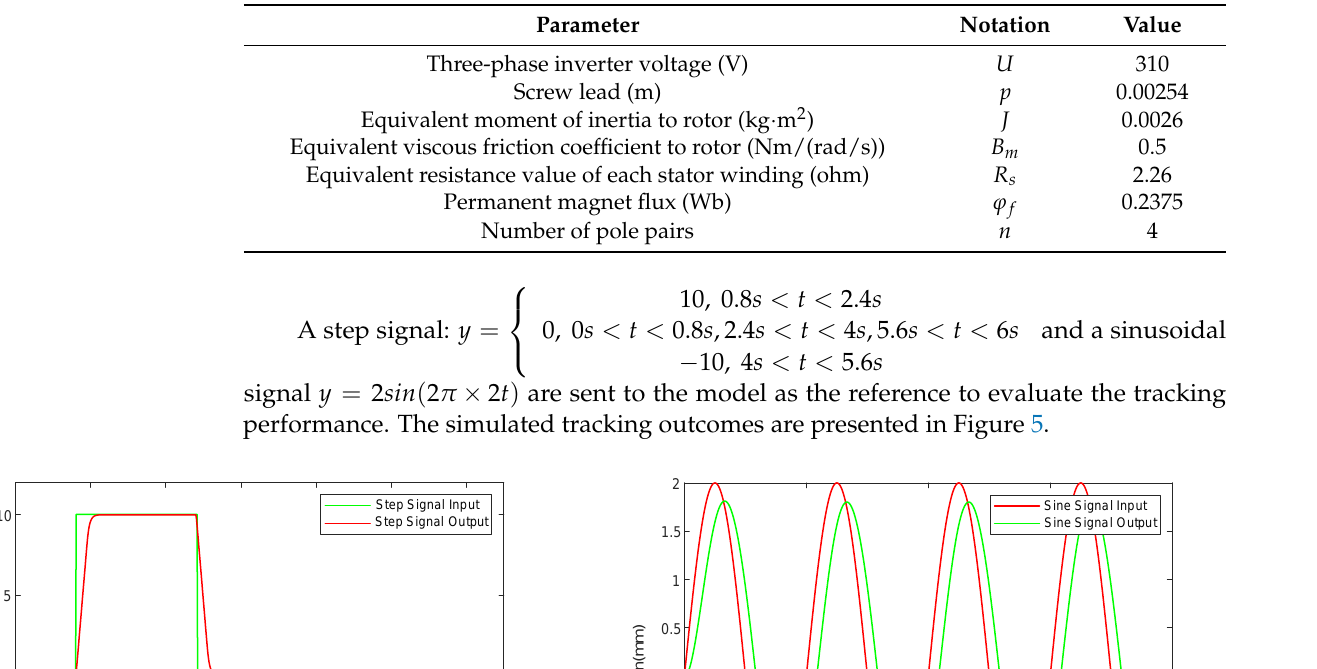
Table 1. Specifications for EMA model simulation.